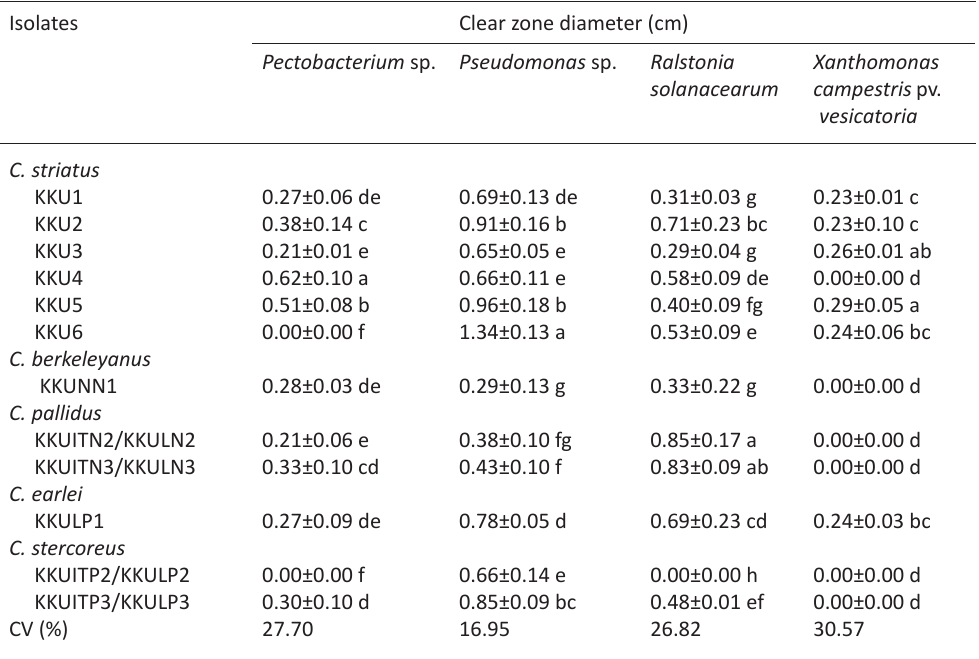
Table 1 Efficacy of Cyathus spp. to control plant pathogenic bacteria by dual culture technique.